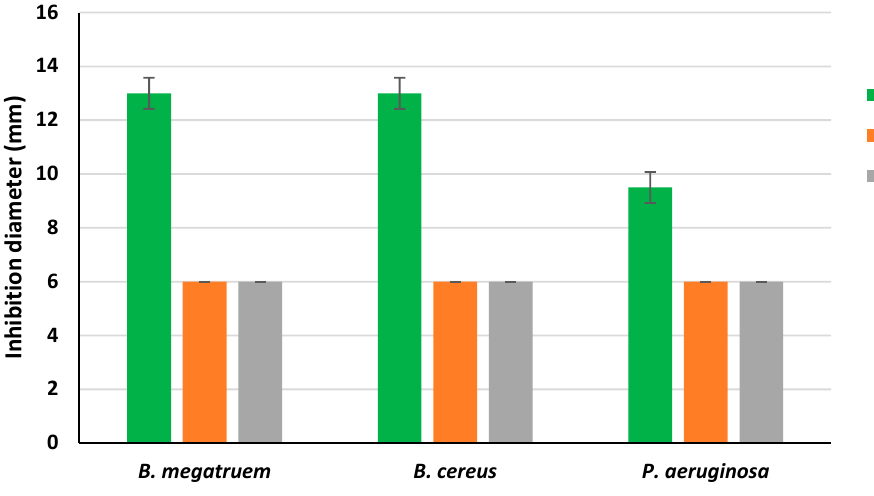
Figure 5. Paper-disk diffusion assay results for methanol extract of S. wertheimae aphids and vegetative part methanolic extract. Bars are average of triplicates and error bars present one SD. Bacteria are as in Figure